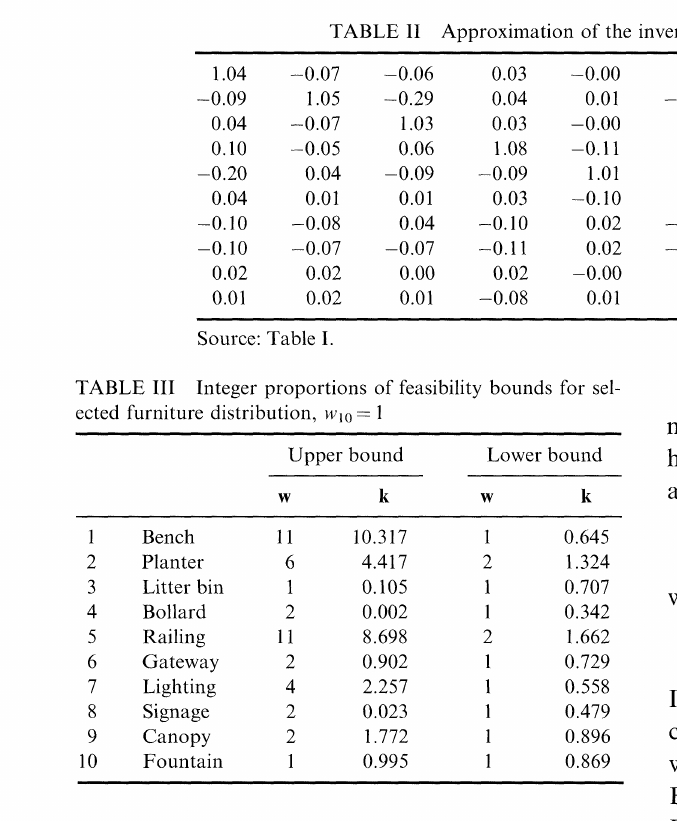
TABLE II Approximation of the inverse A -1, selected street furniture